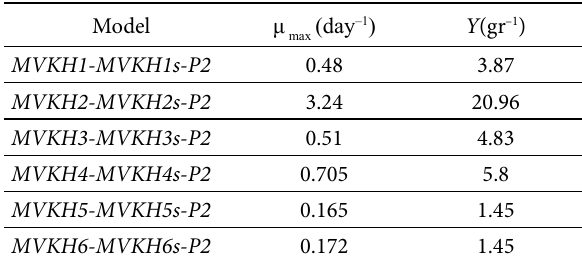
Table 8. The values of μ and Y calculated by nonlinear max regression in each six various combinations of the second simulation case